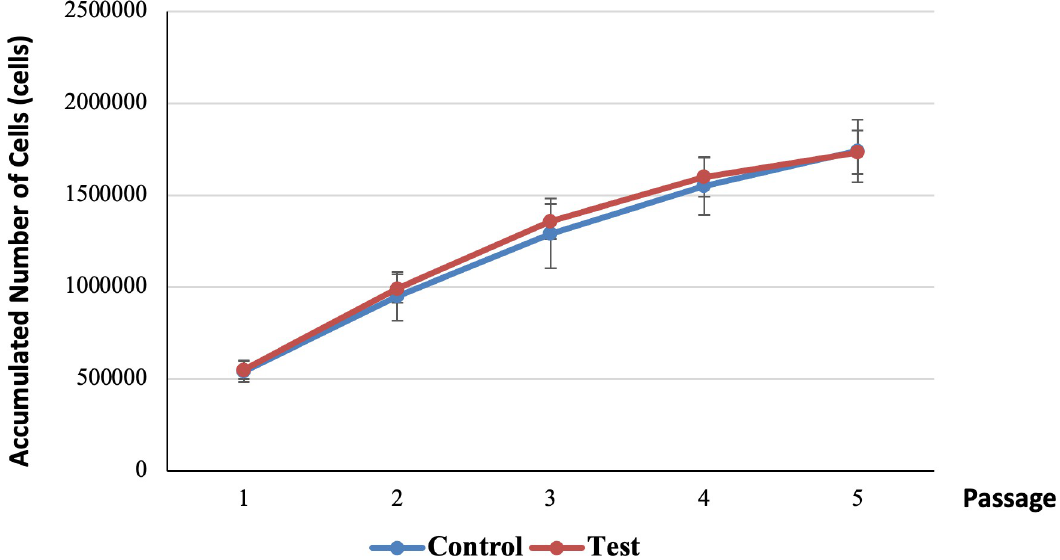
Fig 4. Growth curves of control and test groups up to passage